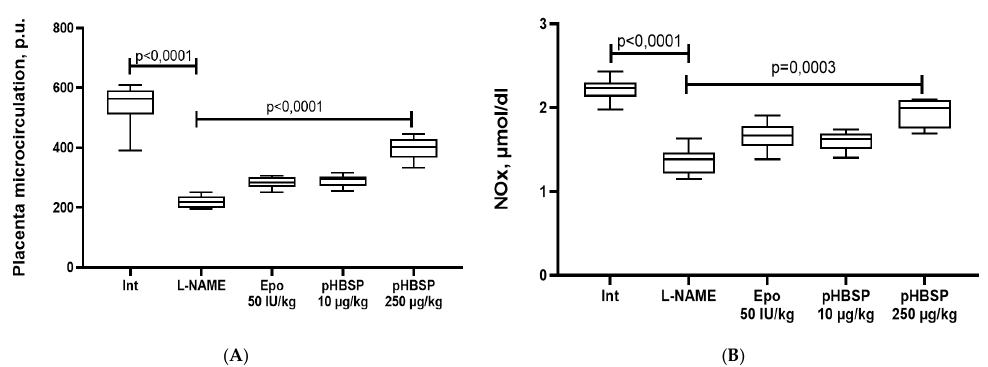
Figure 2. The effect of pHBSP on placental microcirculation ( A ) and the concentration of final stable nitric oxide metabolites (NOx) ( B ) in animals with ADMA-like preeclampsia ( n = 10 animals in each group).